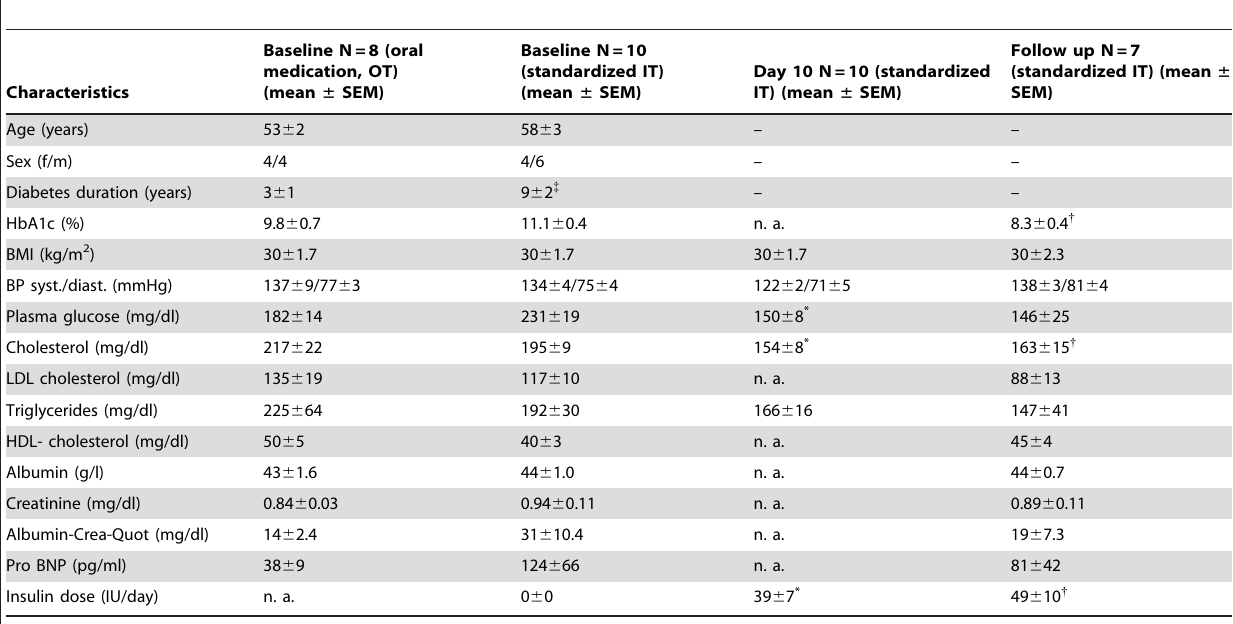
Table 1. Clinical and biochemical characteristics of patients with T2DM treated with standardized IT compared with individuals under oral anti-diabetic therapy